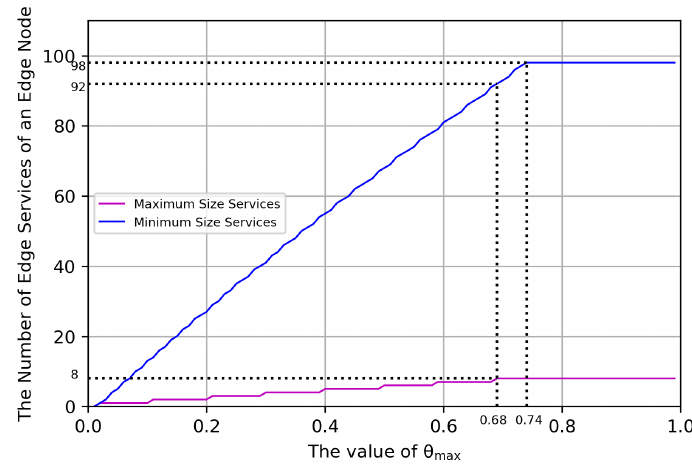
Figure 5. The relationship between the value of θ max and the total number of edge services.